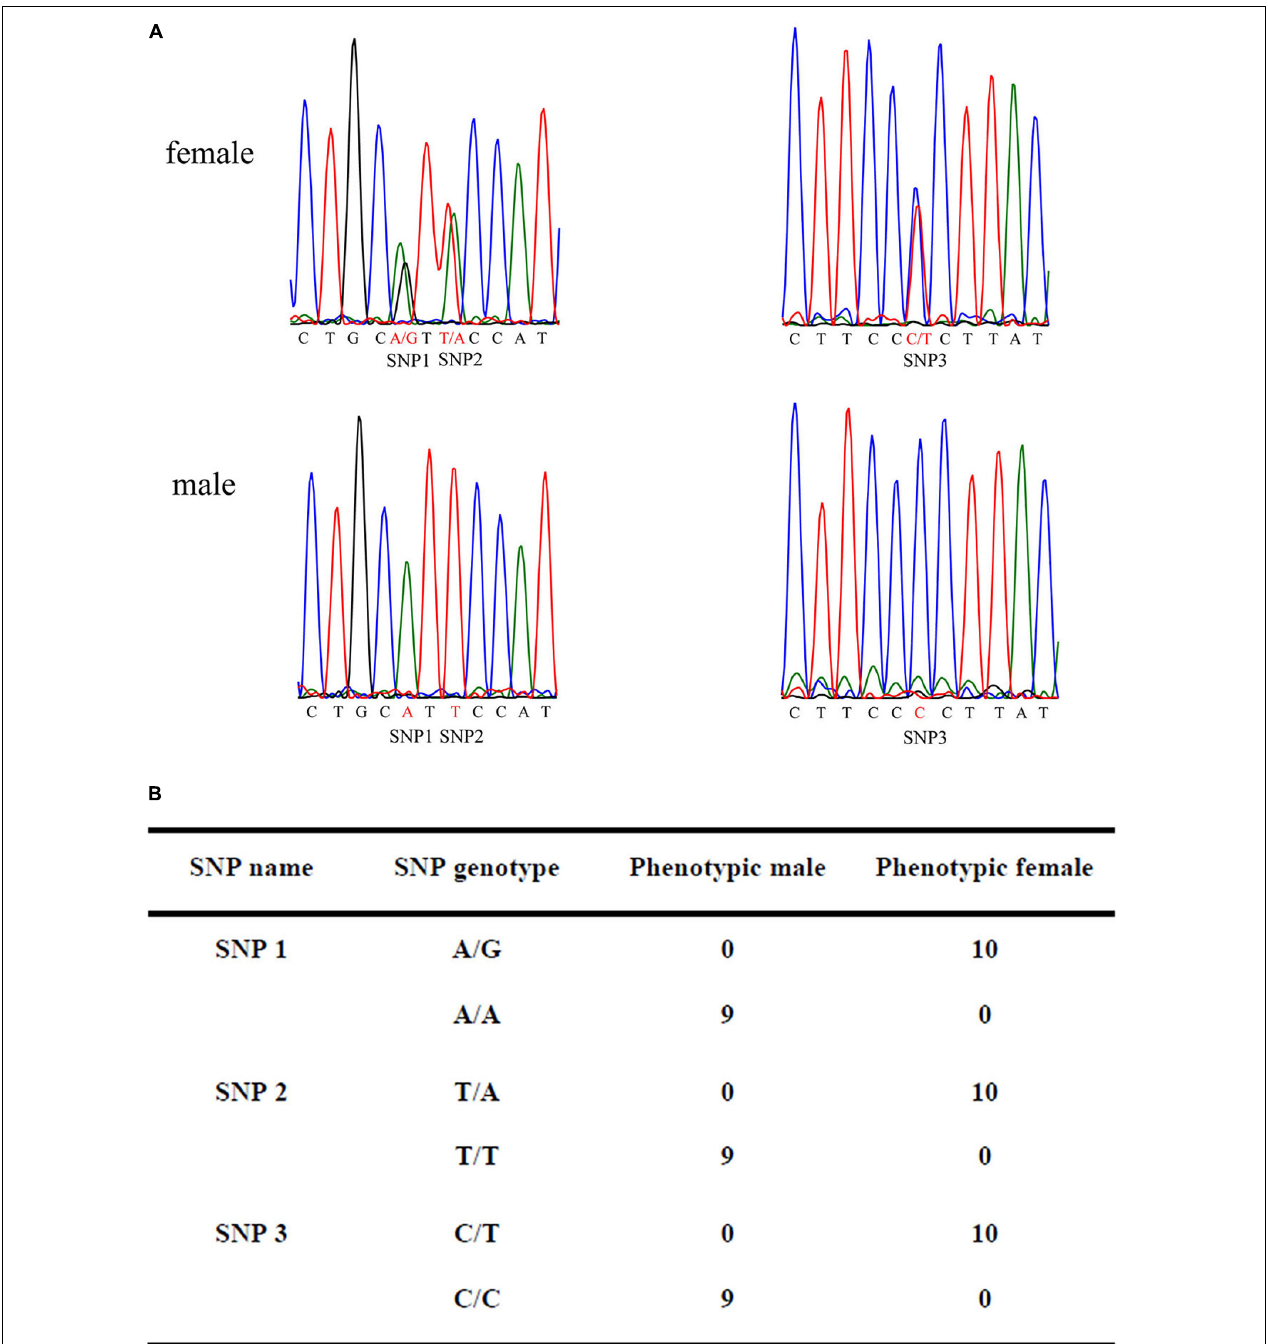
FIGURE 2 | Validation of candidate sex-specific SNP loci in 10 females and 9 males. (A) Three female-specific SNP markers in the sequencing chromatograms of the sex-related sequence of M. nudus . (B) Statistics of sexual phenotype and SNP genotype of the 10 females and 9